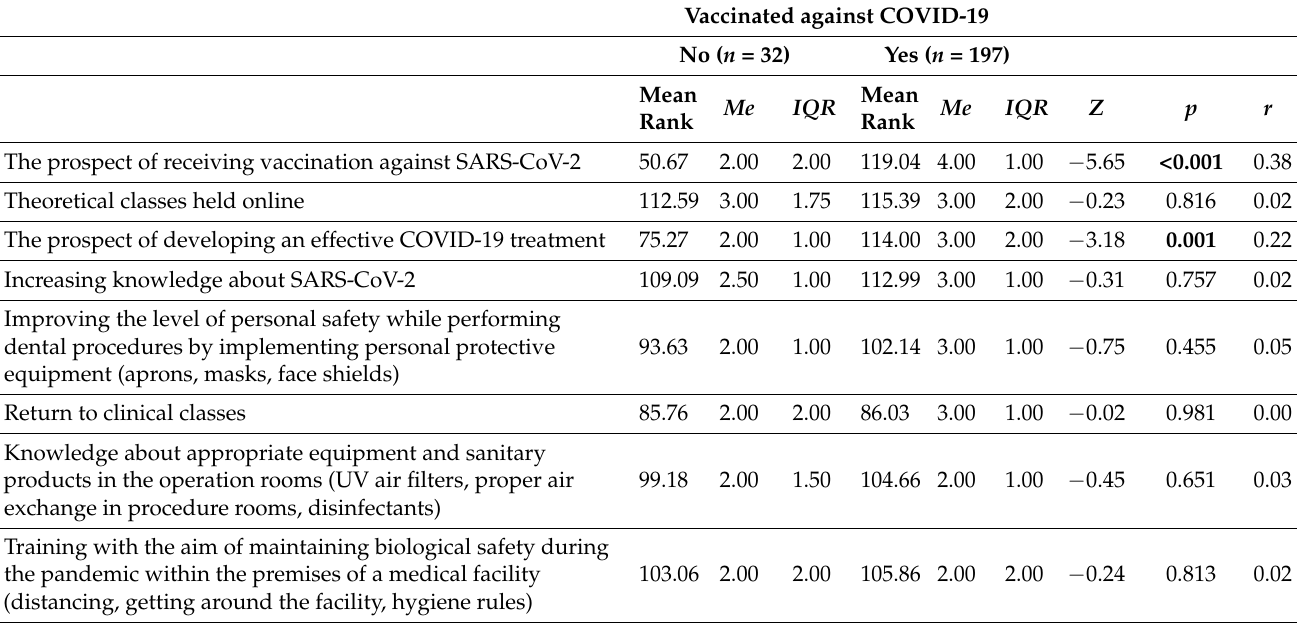
Table 7. Mann–Whitney U test for the comparison of the implemented preventive activities on stress perception between volunteers whose family or relatives had/has not experienced